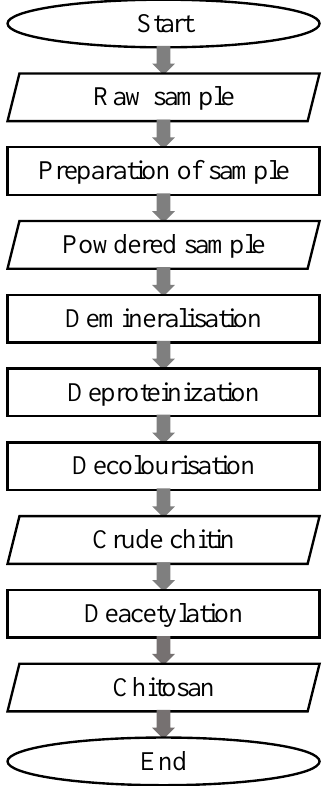
Figure 2. General process for chitin and chitosan extraction.